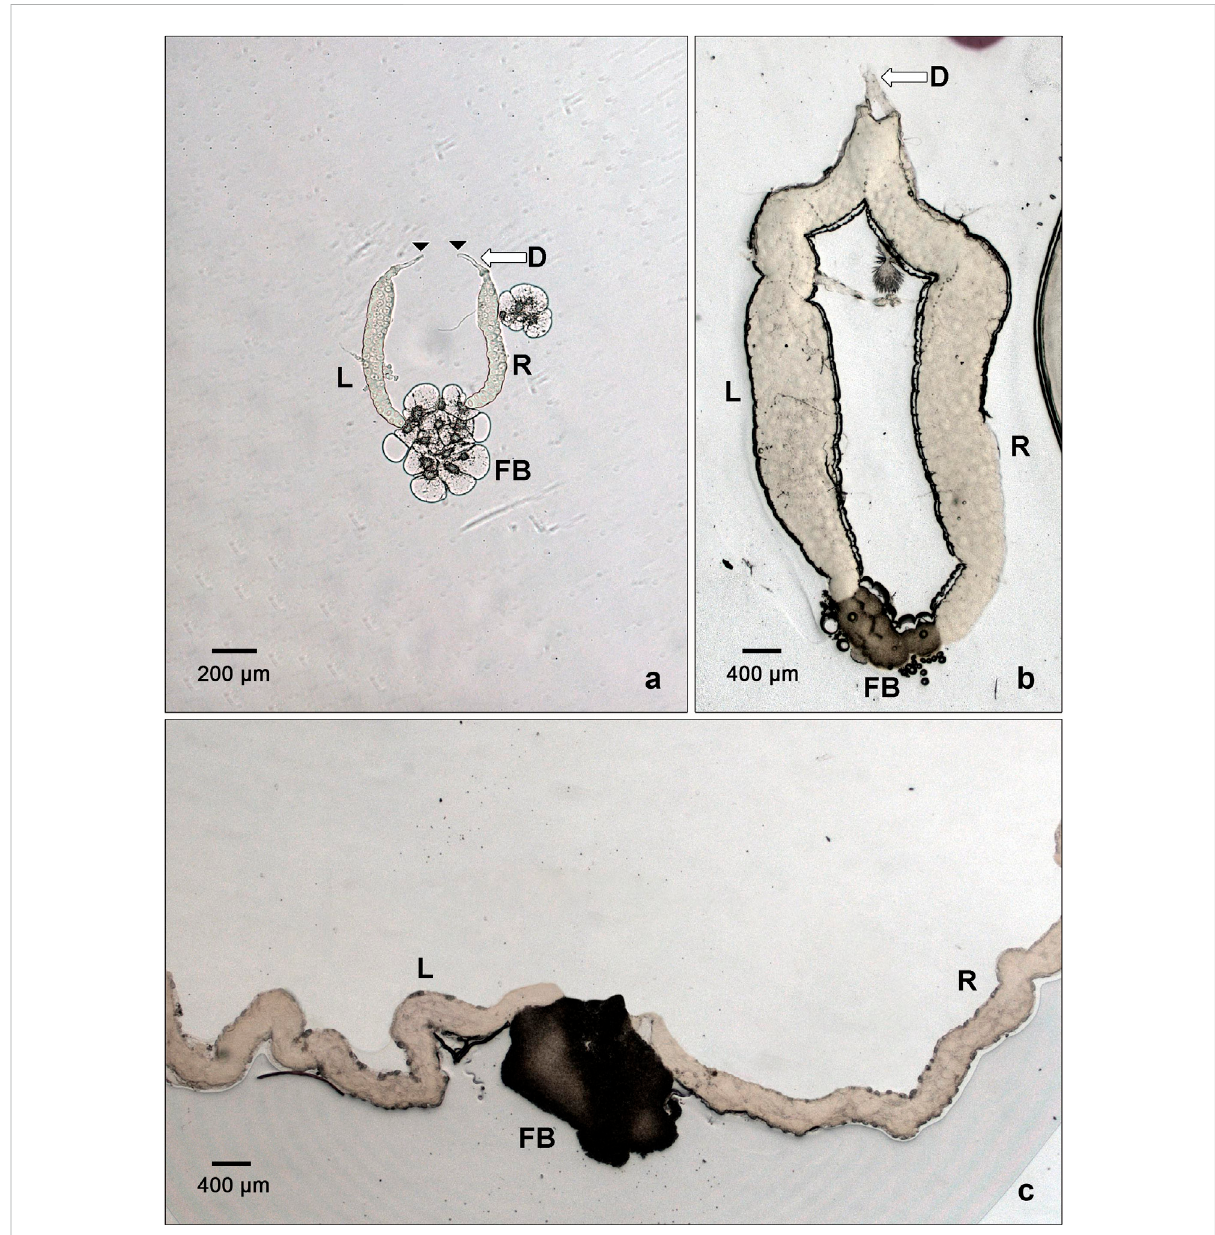
FIGURE 6 TheSGsof C.costata , L.cuprina ,and H.illucens showaccretionorcoalescenceattheirposteriorends.Inallinsects,theanteriorendsoftheSGs typically fuse together to form a common duct. However, it is very rare to see their posterior ends in proximity to each other. This only has been observed ina fewphylogenetically older groups ofinsects, including some dipteran species. In C. costata , the single representative of Drosophilidae among the three species shown here, the posterior ends of the salivary glands appear to be embedded in a broader fat body (FB) area having largefatty cells (A) ;inthispreparationtheanterior ductshave beenseparatedand freed (arrowhead). Inthemaggot fl y, L.cuprina ,theposterior ends of the signi fi cantly larger SGs are glued into a much darker fat body (FB) mass (B) . The ducts (D) of these glands are much shorter and thicker than in other dipteran species and are not easily separable. (C) illustrates that the SGs of H. illlucens are at least 5-times longer than those of L. cuprina . Consequently, their anterior ends are out of the imageable area even at lowest usable magni fi cation (lense 2.5×). Their posterior ends are impaled into a dark mass that appears to be a fat body (FB). L, left gland lobe; R, right gland lobe. The scale bars in the lower left corners represent 200 or 400